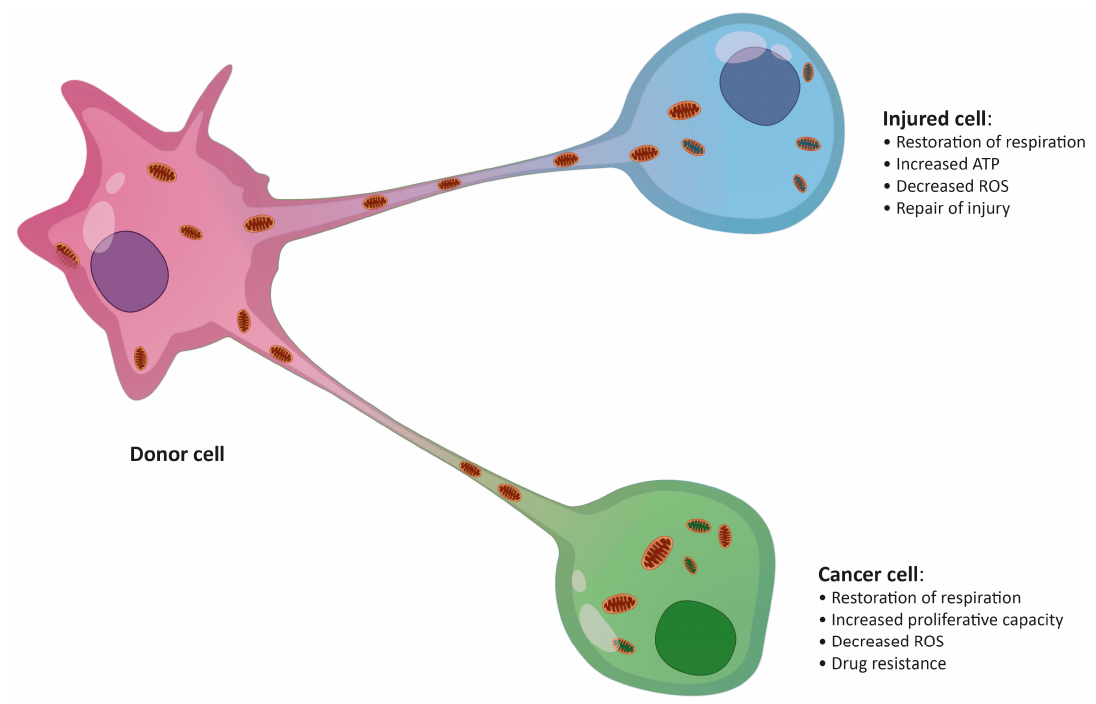
Figure 1. Putative effects of mitochondrial transfer on an injured cell and a cancer cell. ROS, reactive oxygen species.